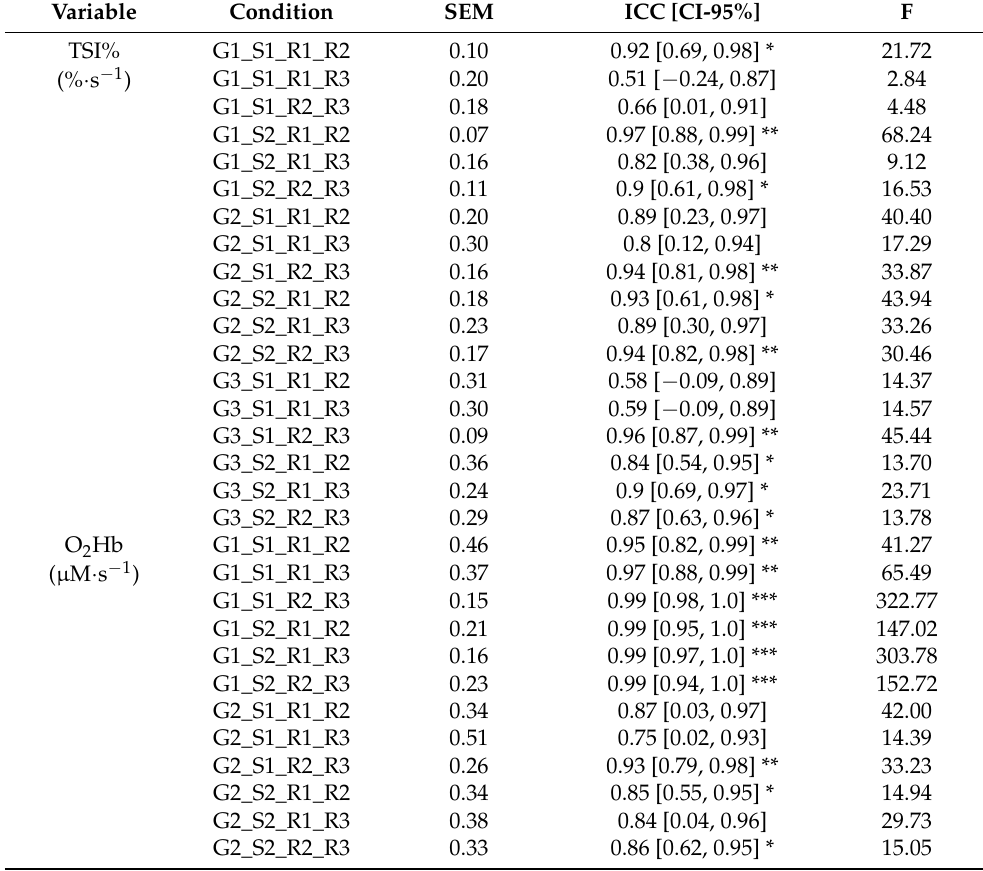
Table 8. Within-participant reliability for Vpeak of reoxygenation